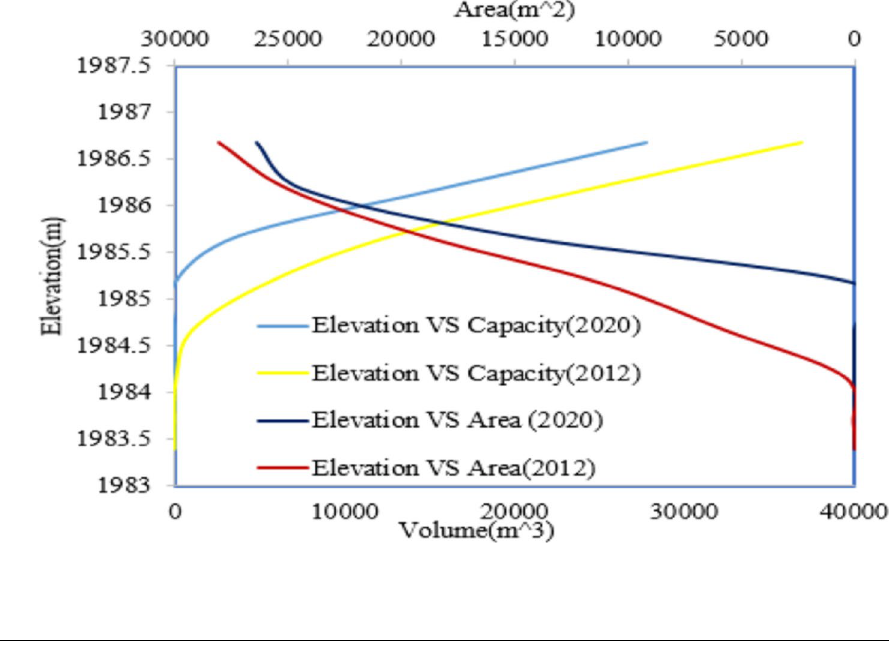
Table 6 Adebra NSR